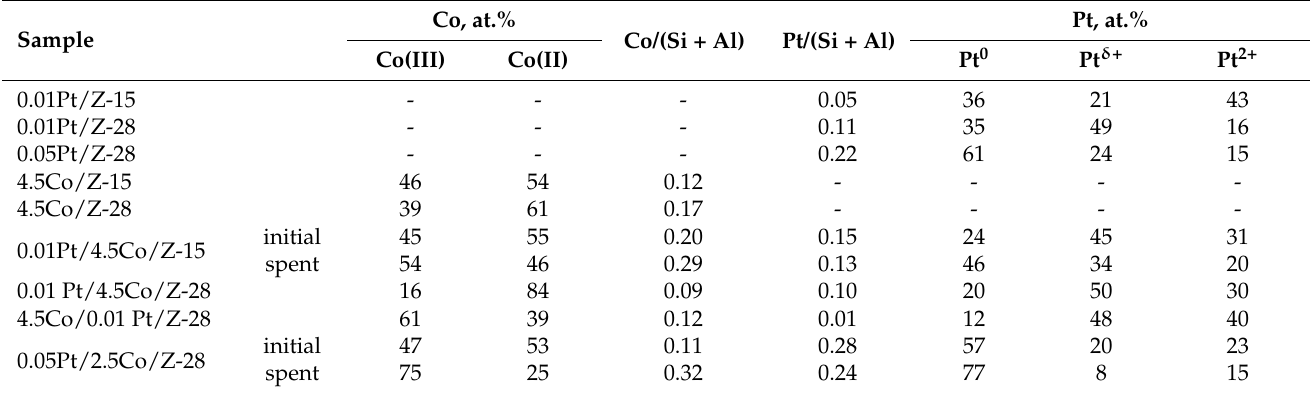
Table 4. Percentages of different Pt and Co states and the relative surface content in Pt- and Co- modified zeolites (initial and spent in CO-PROX) determined by